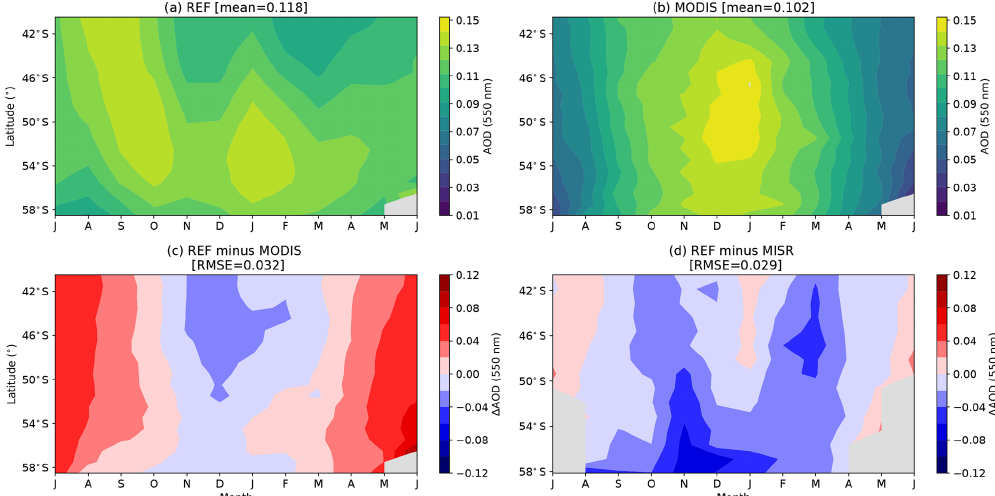
Figure 1. (a) Monthly climatological zonal-mean aerosol optical depth (AOD) at 550nm between 2003 and 2007 for the REF simulation performed with the modified HadGEM3-GA7.1 model. Daily-mean model data were temporally co-located with daily-mean MODIS satellite data. The grey shaded area indicates where MODIS data are unavailable, and the mean AOD is indicated in the title. (b) As for panel (a) but showing AOD measured by MODIS-Aqua (the Moderate Resolution Imaging Spectroradiometer) collection 6.1. (c) The difference between HadGEM3-GA7.1-mod and MODIS; i.e. panel (a) minus (b) . The root mean square error (RMSE) is indicated in the title. (d) As for panel (c) but showing the difference between HadGEM3-GA7.1-mod and MISR (Multi-angle Imaging Spectroradiometer).